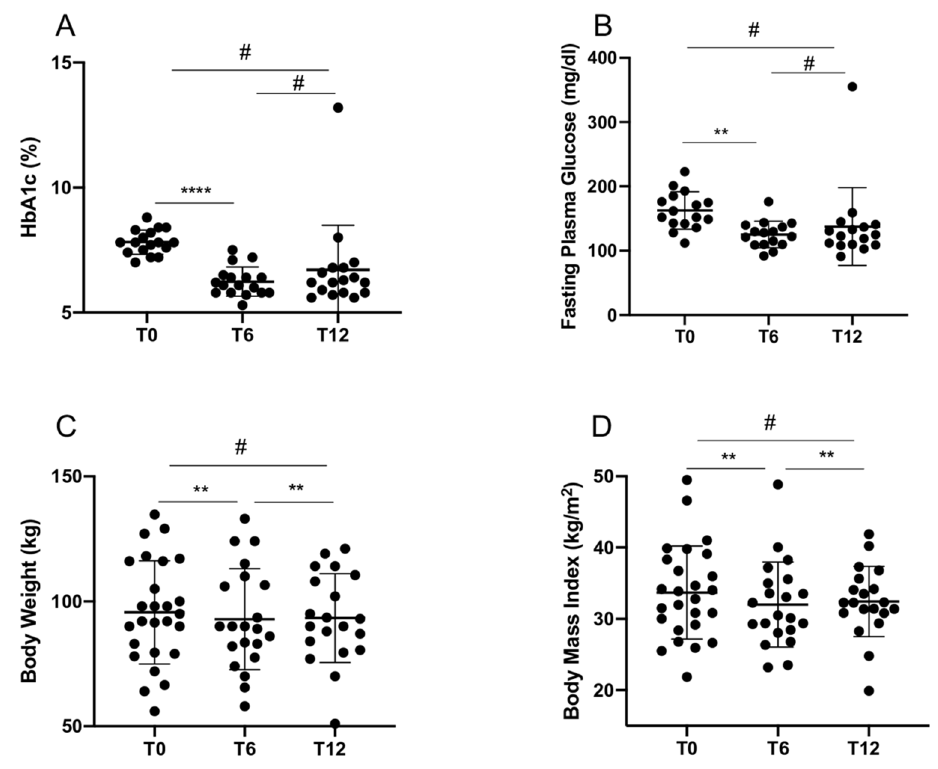
Figure 1. Comparison of HbA1c values ( A ), fasting plasma glucose ( B ), body weight ( C ) and body mass index ( D ) between baseline (T0) and after 6 (T6) and 12 (T12) months of treatment. Statistics using repeated measures one-way ANOVA with Tukey’s multiple test. # p not significant; **** p < 0.0001; ** p < 0.01. Table 2. Anthropometric measures and metabolic data in patients treated with dulaglutide or liraglutide, before and after therapy.